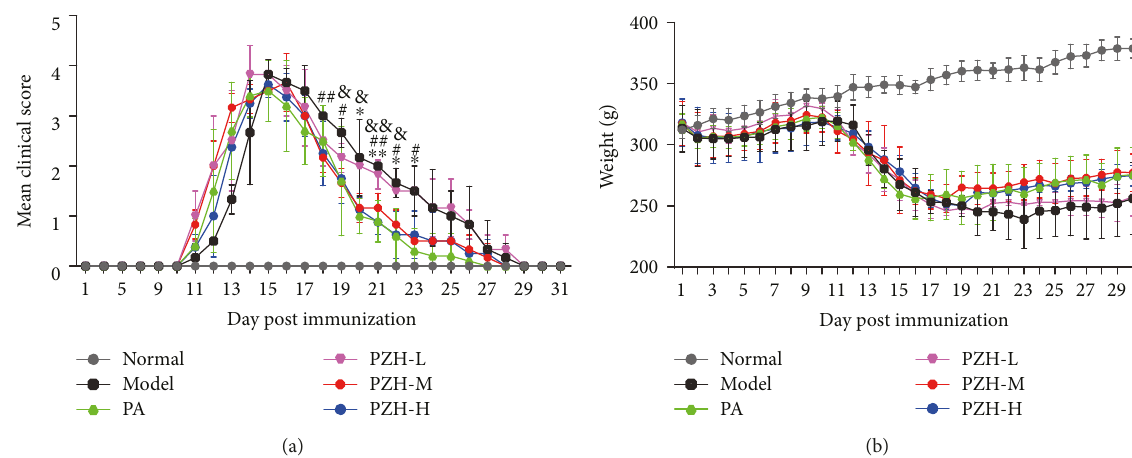
Figure 1: PZH ameliorated clinical symptoms of EAE rats. (a) Time course changes of the mean clinical score in rats from the respective group. (b) Time course changes of body weight in rats from the respective group. Results are shown as mean ± SD. ∗ P < 0 05 and ∗∗ P < 0 01 ; PA group versus model group. # P < 0 05 and ## P < 0 01 ; PZH-M group versus model group. & P < 0 05 and && P < 0 01 ; PZH-H group versus model